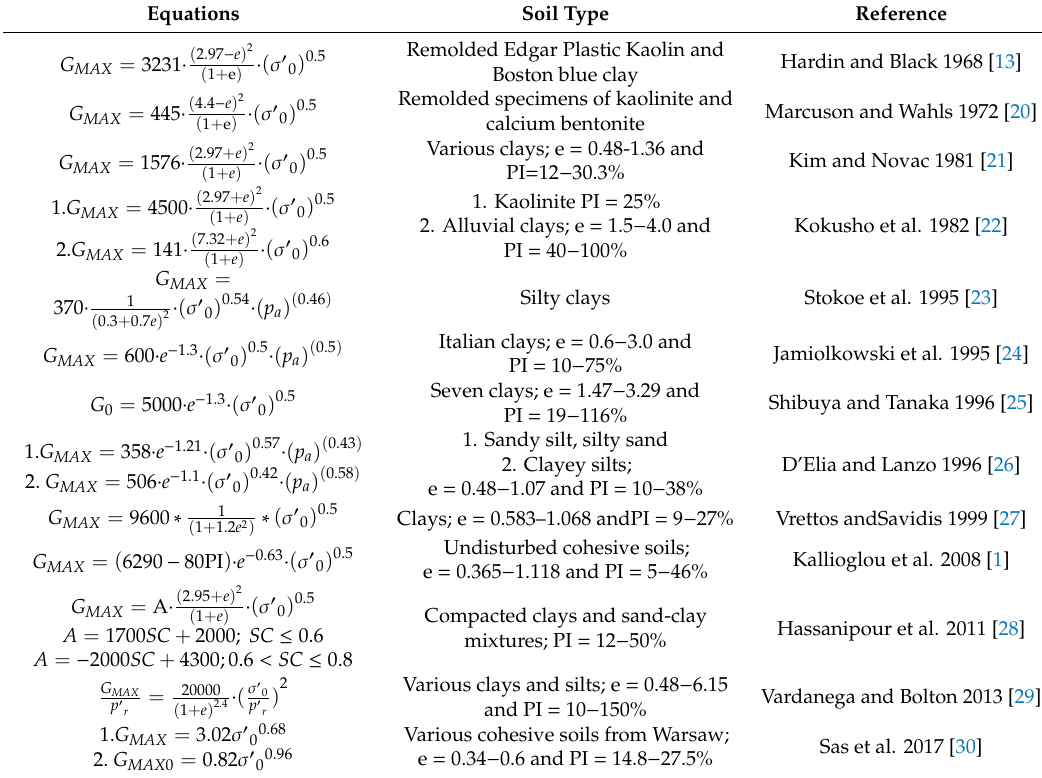
Table 1. Relationships for G MAX of cohesive